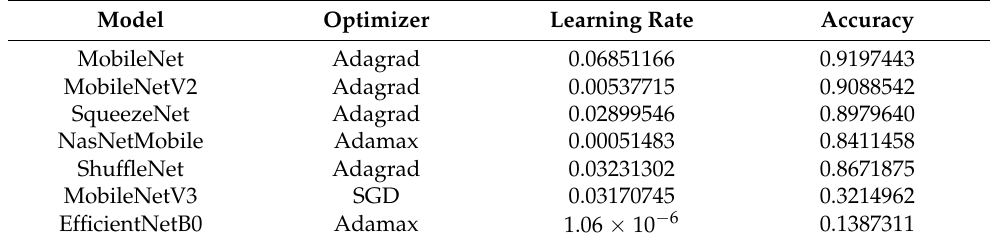
Table 3. Results of the Bayesian Optimization applied to the preselected models.